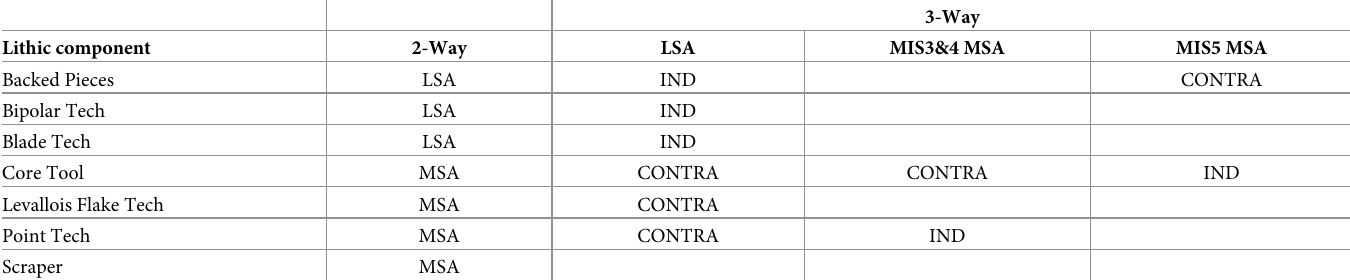
Table 7. Summary of significant indicators and contra-indicators from the 3-way (first three columns) and 2-way (final column) analyses. Details as per Table